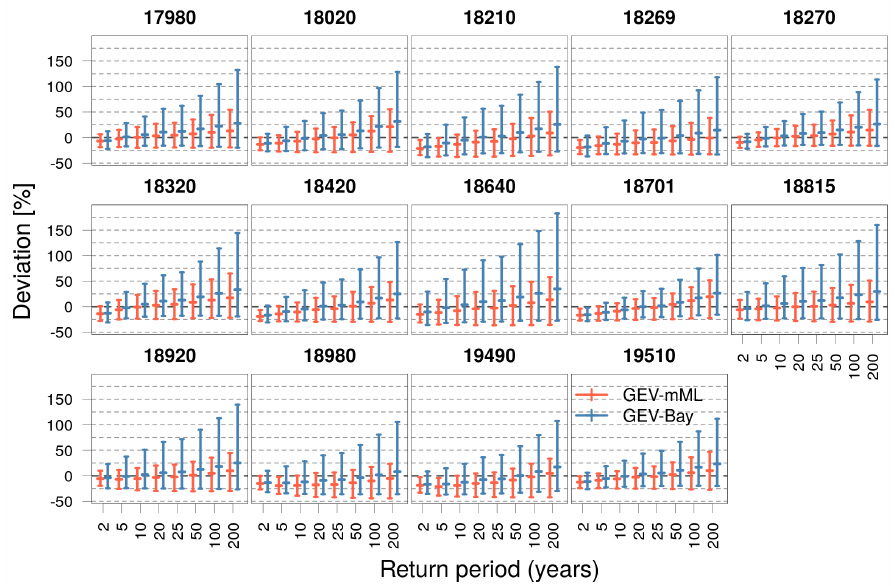
Figure 4. Relative difference to return levels from Gumbel-RV for GEV-mML (red) and GEV-Bay (blue) for all stations and all return periods. Only the 60 minute precipitation is shown. The bars indicate the 95% confidence or credible interval.